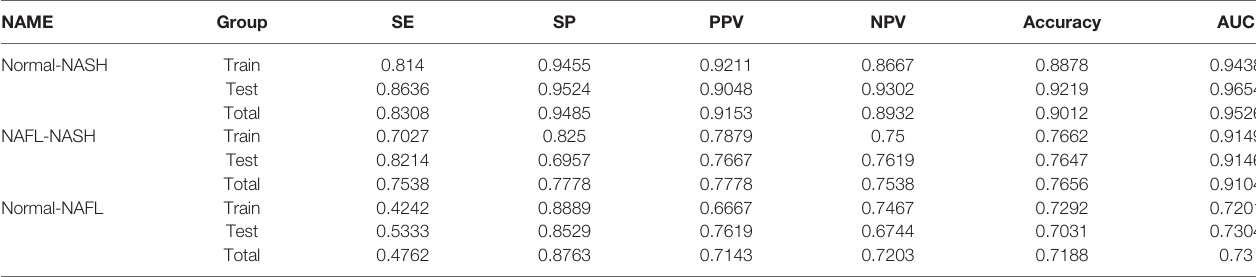
TABLE 4 | Validation of LASSO logistic regression classi fi